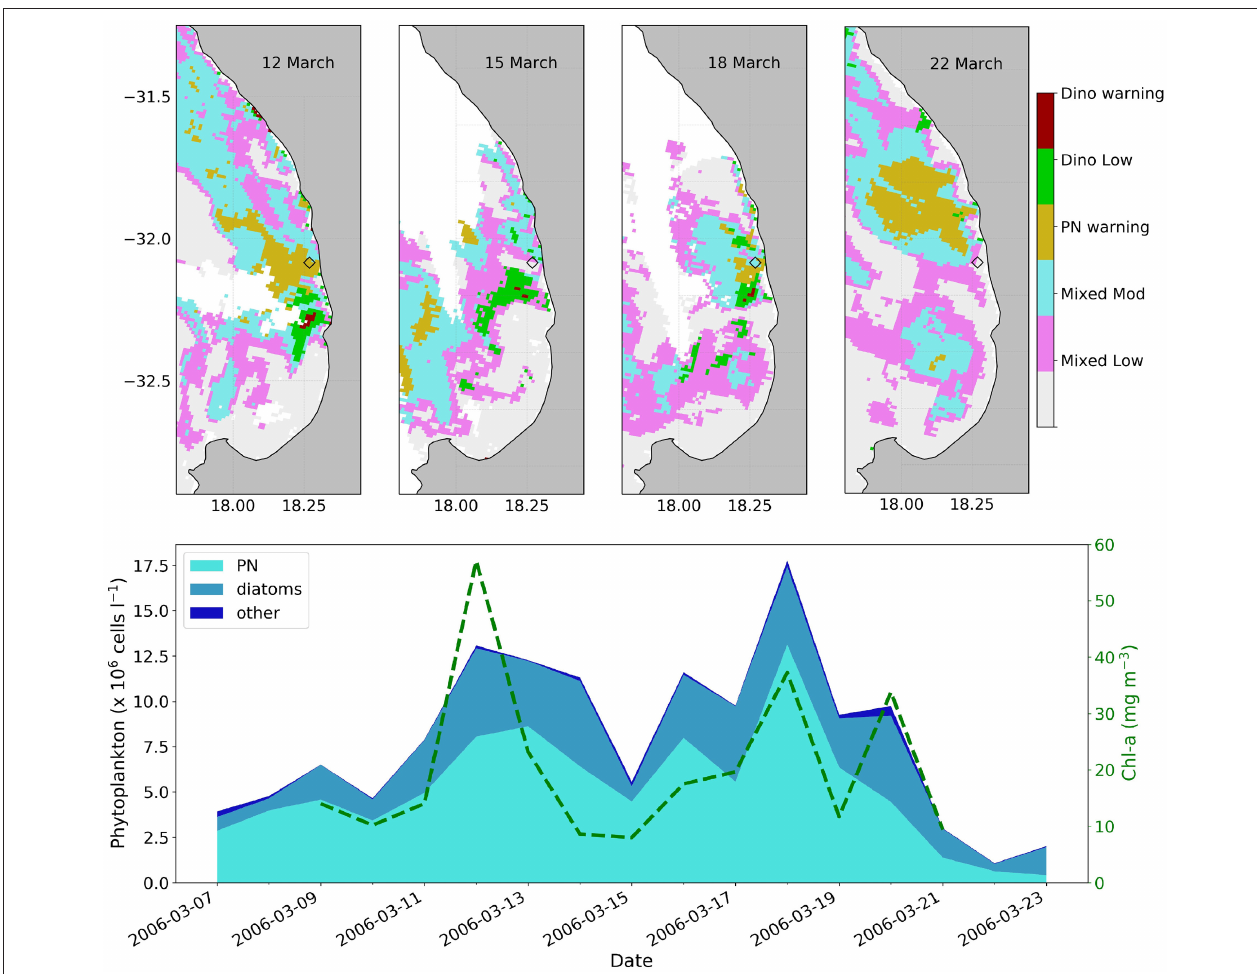
FIGURE 7 | The top panels show the satellite-derived probabilistic phytoplankton community classification (PPCC) from MERIS for the 12th, 15th, 18th, and 22nd of March 2006, with the location of the Lambert’s Bay sampling station indicated by a diamond; classes include high biomass dinoflagellate blooms (red), dinoflagellate dominated blooms of moderate biomass (green), Pseudo-nitzschia (yellow) dominated waters, as well as high (blue) and low (pink) biomass mixed assemblages. Please refer to Table 2 for a detailed PPCC color key. The lower panel provides the phytoplankton count data at the Lambert’s Bay station for the 2006 sampling period (adapted from Fawcett et al., 2007), with available in situ [Chl-a]